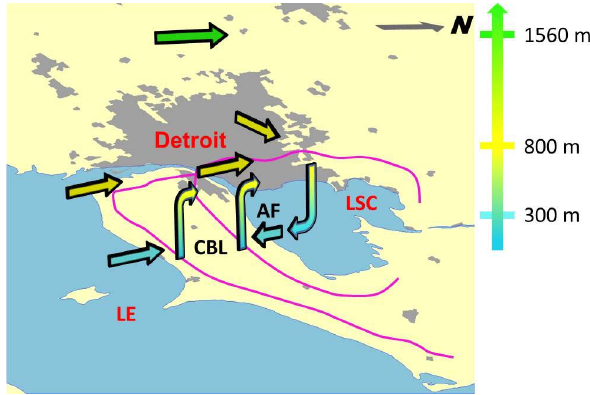
Fig. 11. Flight 4 perspective view. Surface position of lake-breeze fronts shown as magenta lines and the lake-breeze motions shown as arrows coloured according to altitude.